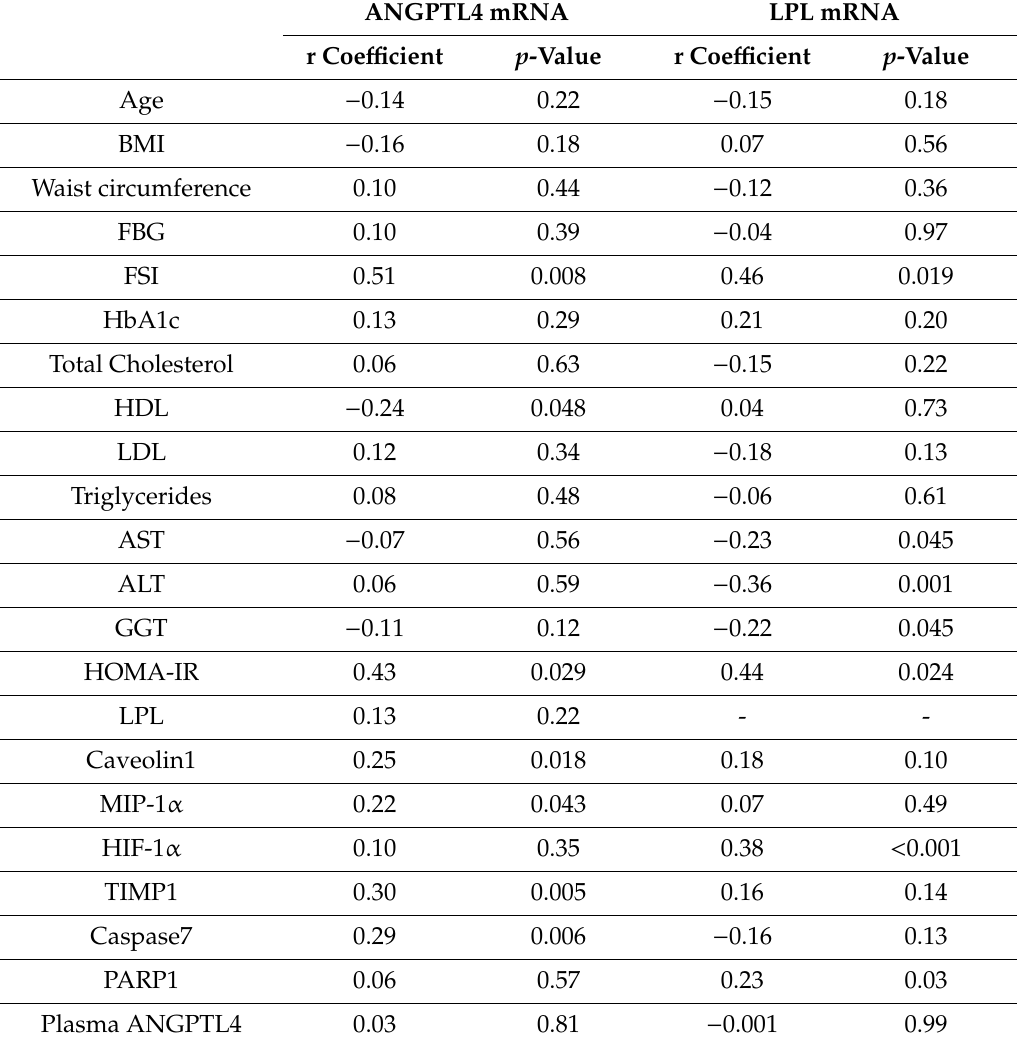
Table 2. Bivariate correlation analyses between (A) ANGPTL4 and (B) LPL mRNA expression and